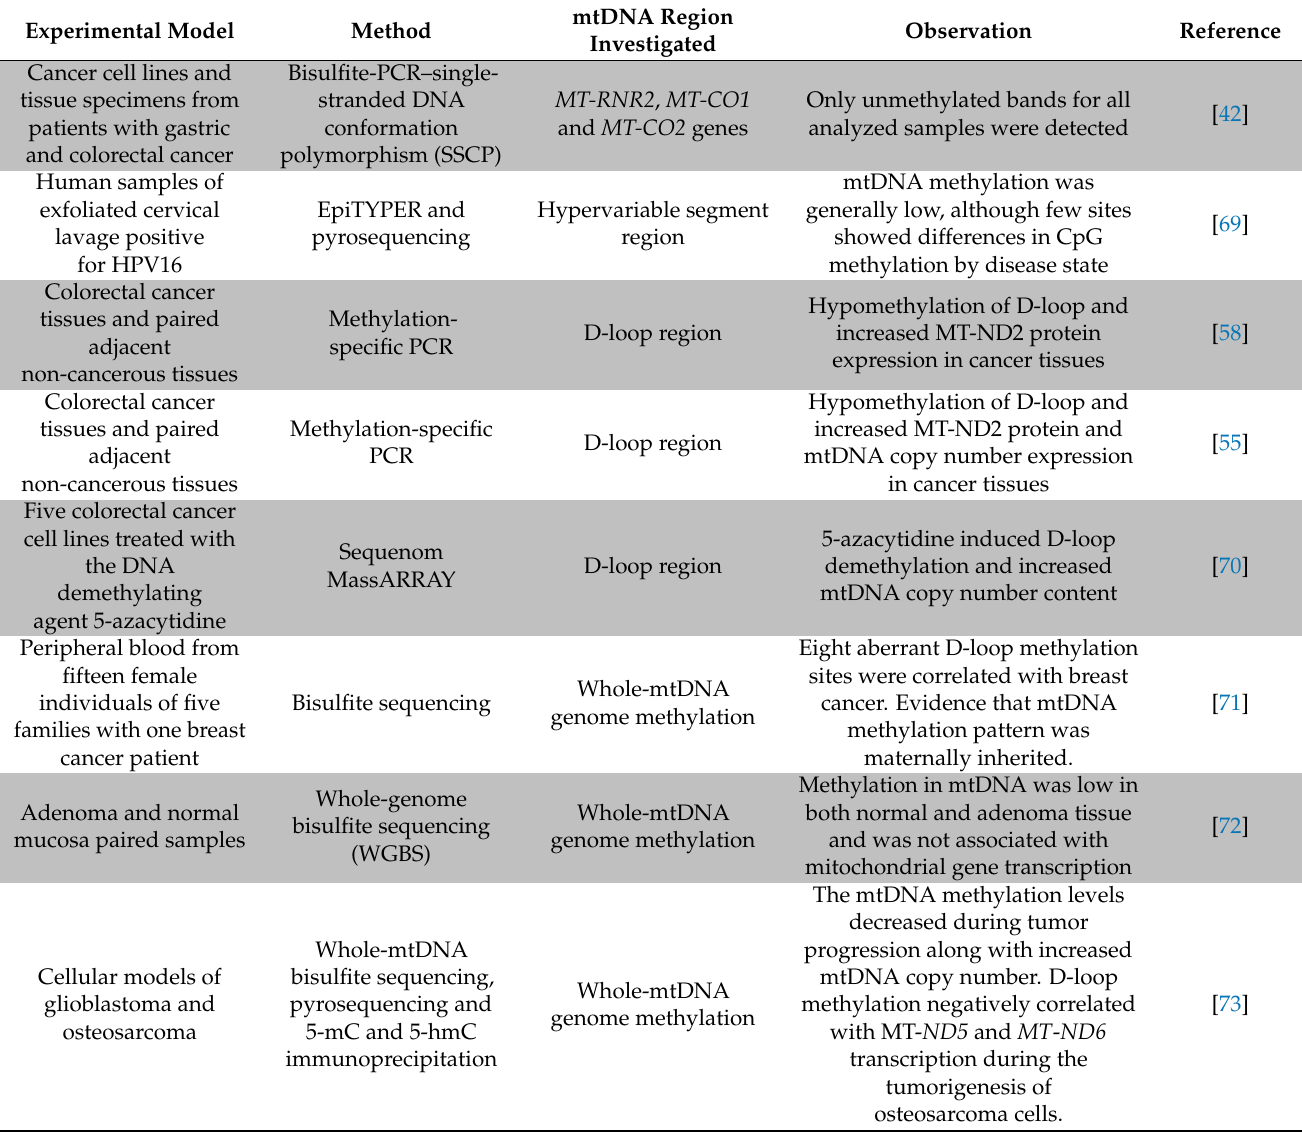
Table 1. mtDNA methylation studies in